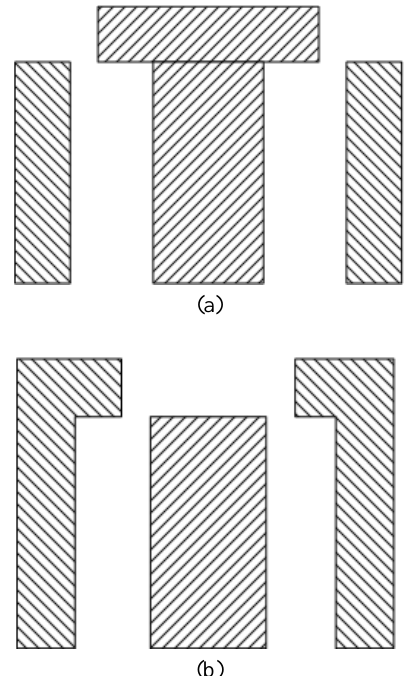
Fig. 11. Two basic designs of air outlet nozzle